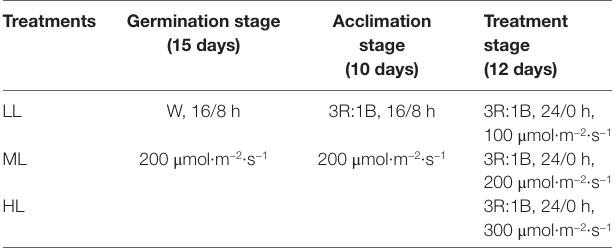
W: white LED light, 3R:1B: red and blue LED light with a ratio of 3:1.